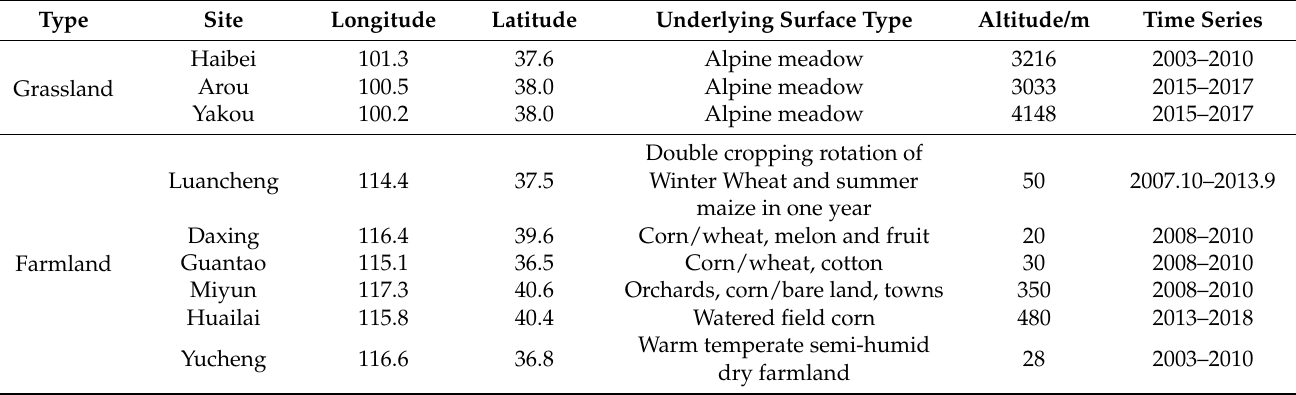
Table 1. Basic information of flux